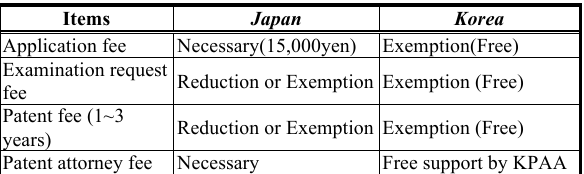
C OMPARISON ABOUT SUPPORT SYSTEM OF STUDENT P ATENT APPLICATION BETWEEN J APAN AND K